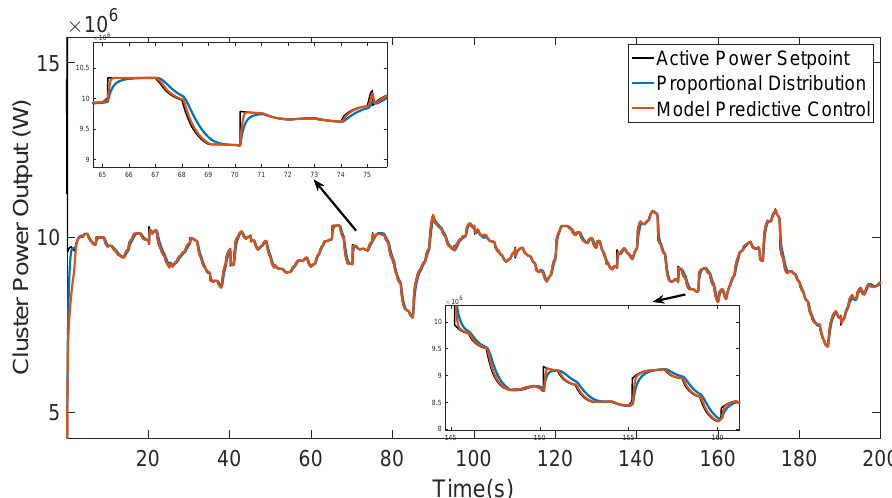
Figure 9. Four-units cluster robustness test—cluster power output under varying power demand.